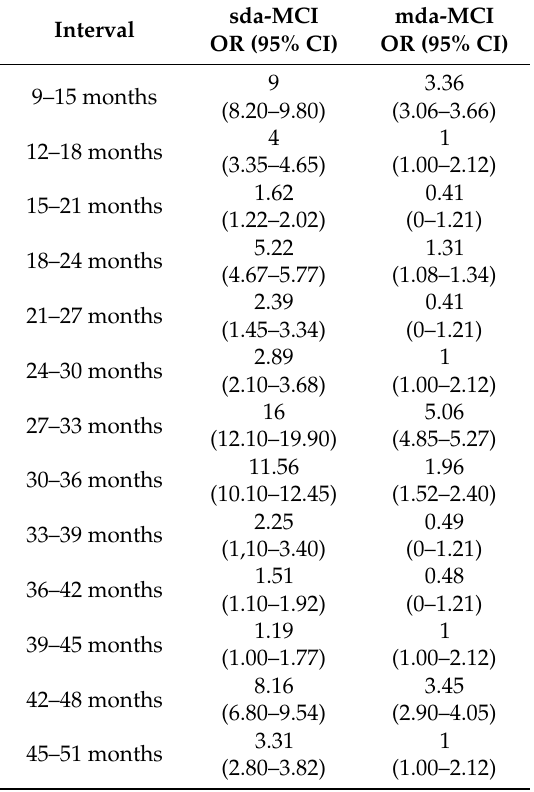
Table 3. Odds ratios for conversion to dementia in sda-MCI and mda-MCI groups relative to